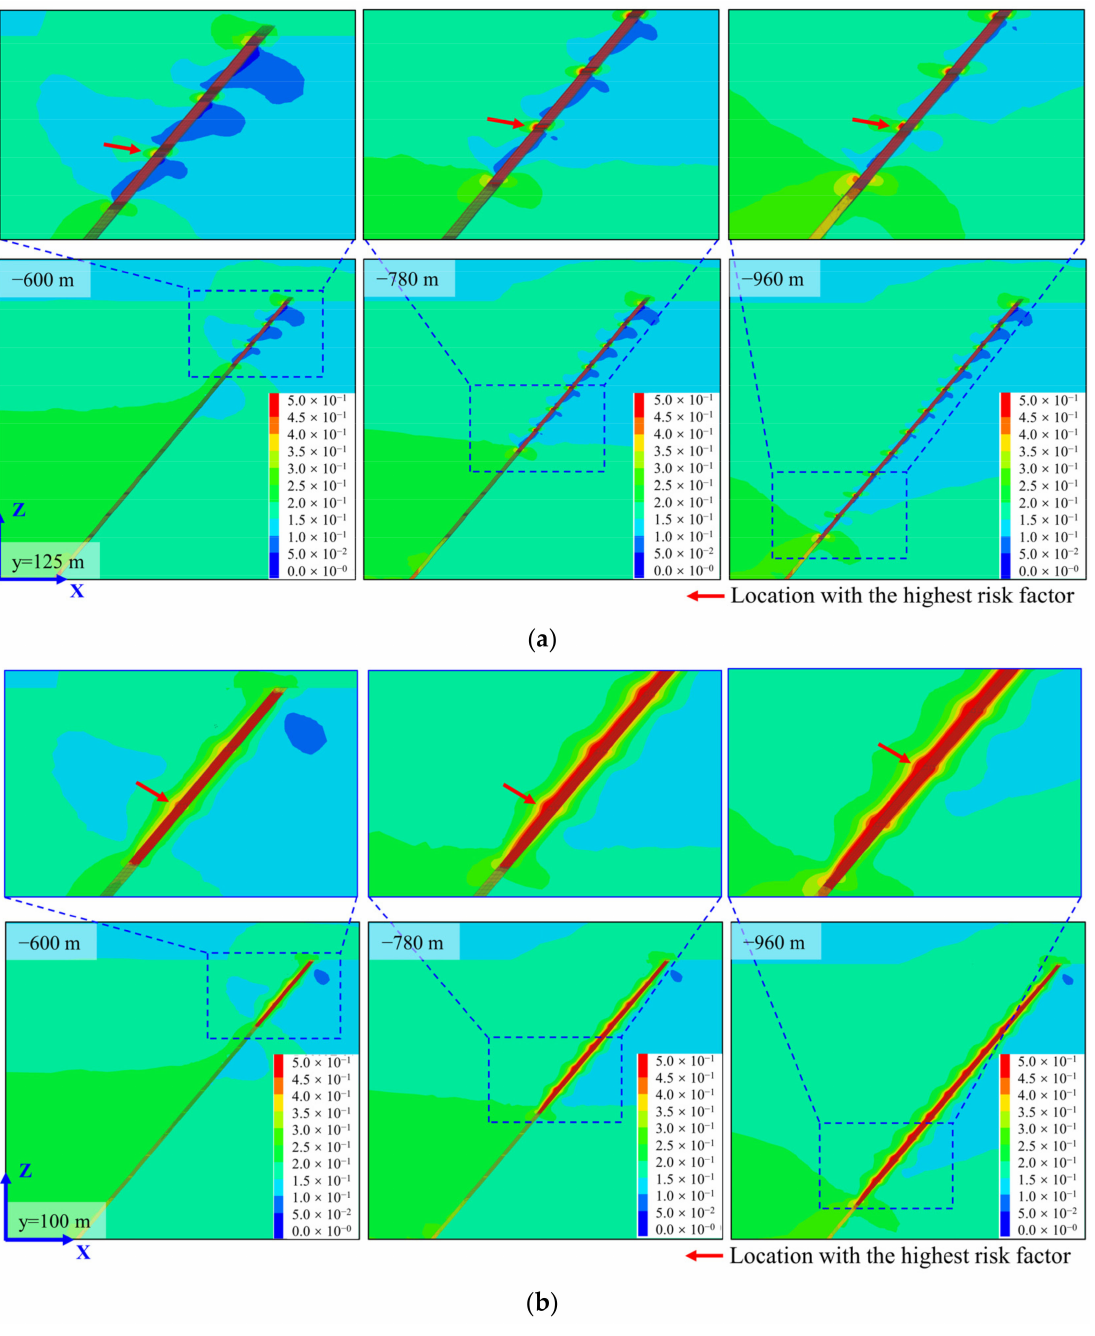
Figure 8. Cloud diagram of risk factor ( σ 1 / σ c (y = 125 m); ( b ) The risk factor along the barrier pillars’ midline (y = 100